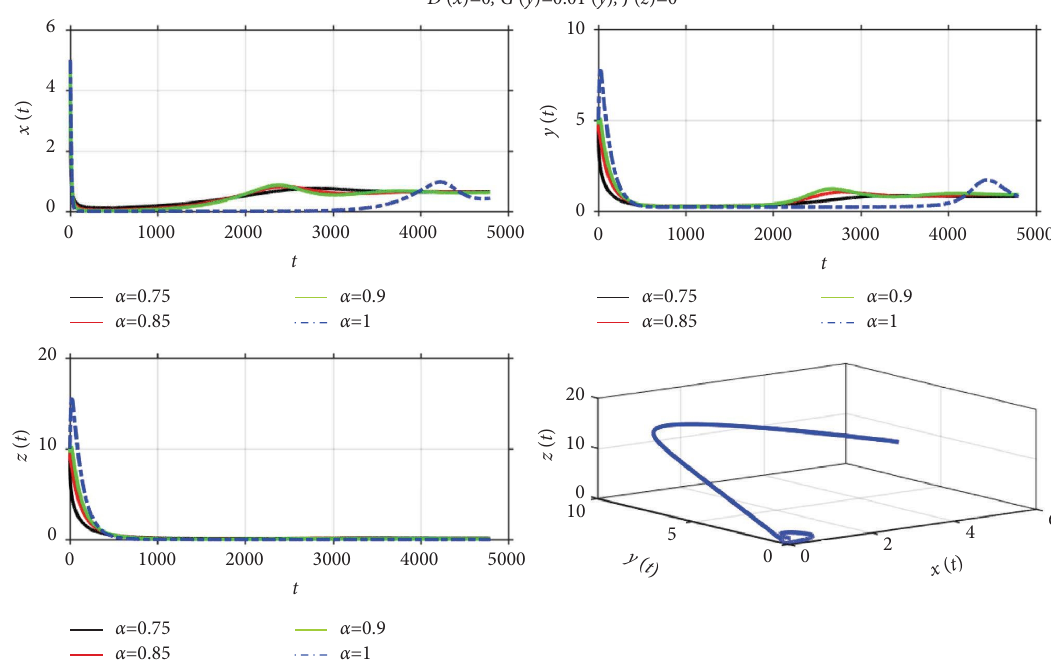
Figure 8: Population dynamics of the one prey-two predators system with D ( x ) � 0 , G ( y ) � g / y � 0 . 01/ y, J ( z ) � 0 , a � b � c � 0 . 1 , e � h � 0 . 3 ,f � i � 0 . 2 , α � 0 . 75 , 0 . 85 , 0 . 9 , 1 , and 3D-plot of x ( t ) ,y ( t ) , and z ( t ) for α � 1 .